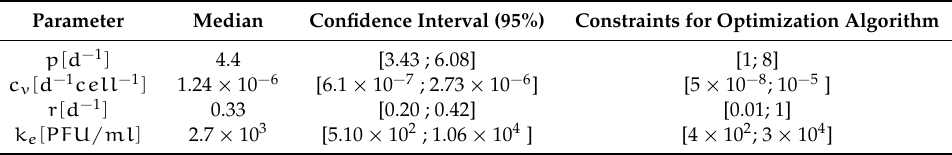
Table 2. Model parameter estimates (median), 95% confidence intervals and constraints used in the optimization algorithm